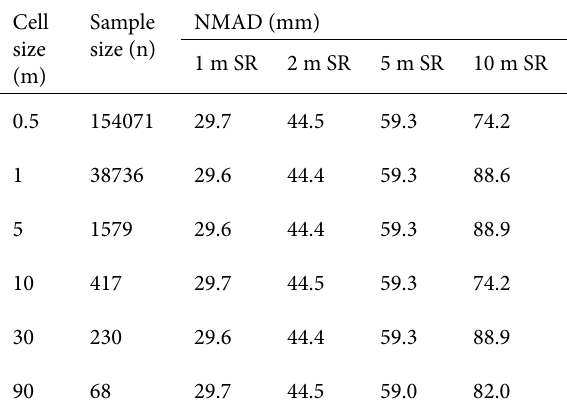
Table 2. NMAD for the DEMs with different combinations of